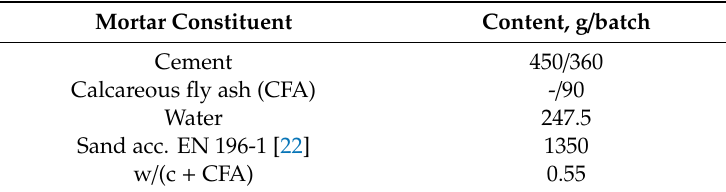
Table 5. Composition of